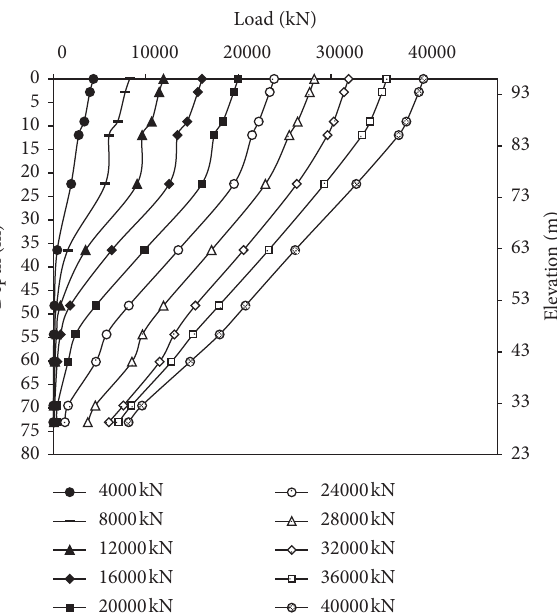
Figure 13: Load transfer mechanism of